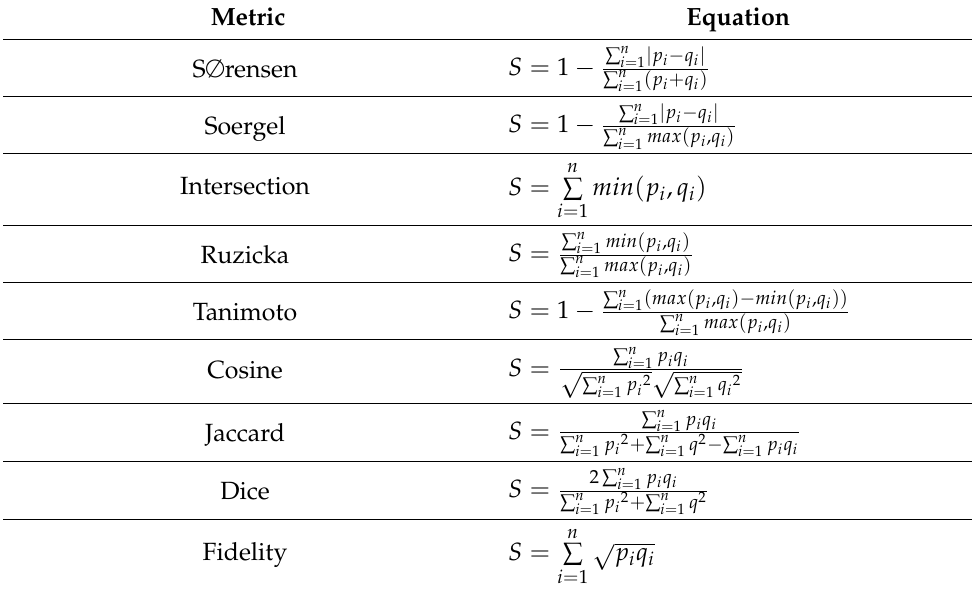
Table 1. Equations of nine similarity measures (S) between PDF pairs, p and q , with n ordinal classes. We selected these nine PDF similarity measures out of the 45 metrics reviewed by [29], as their values ranged from 0 (for a pair of very contrasting PDFs) to 1 (for a pair of exactly matching PDFs); the other metrics reviewed by [29] resulted in similarity values ranging beyond sensible scales (e.g., the metrics of City Blok L1, Czekanowski, and Squared-Chord metrics had values ranging from − 1 to